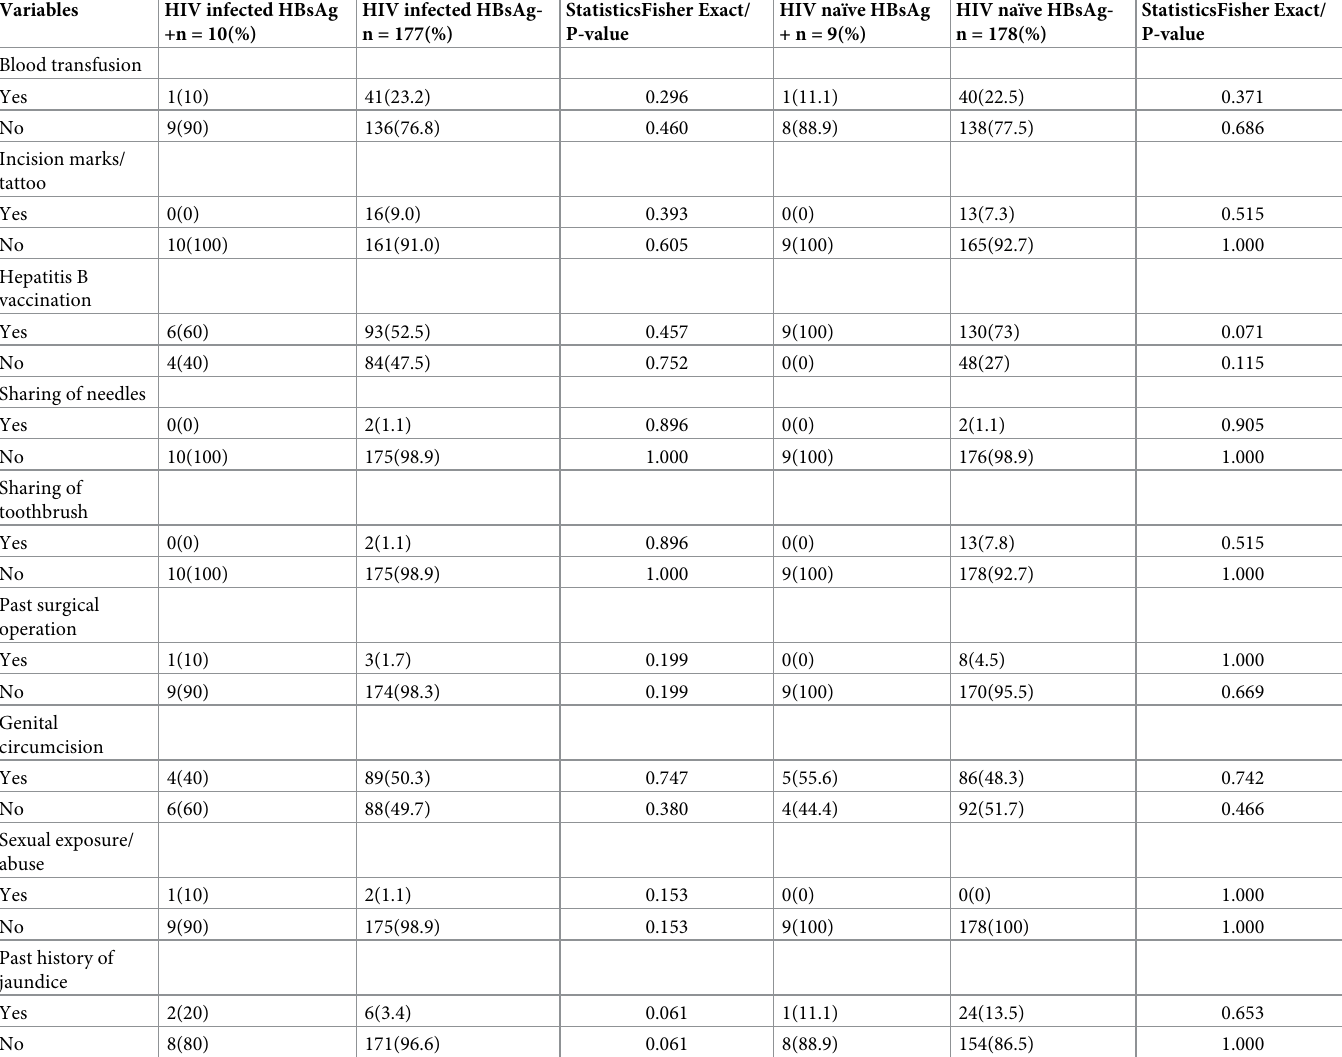
Table 3. Comparison of the risk factors for HBV acquisition among HIV infected and HIV na ï ve children.